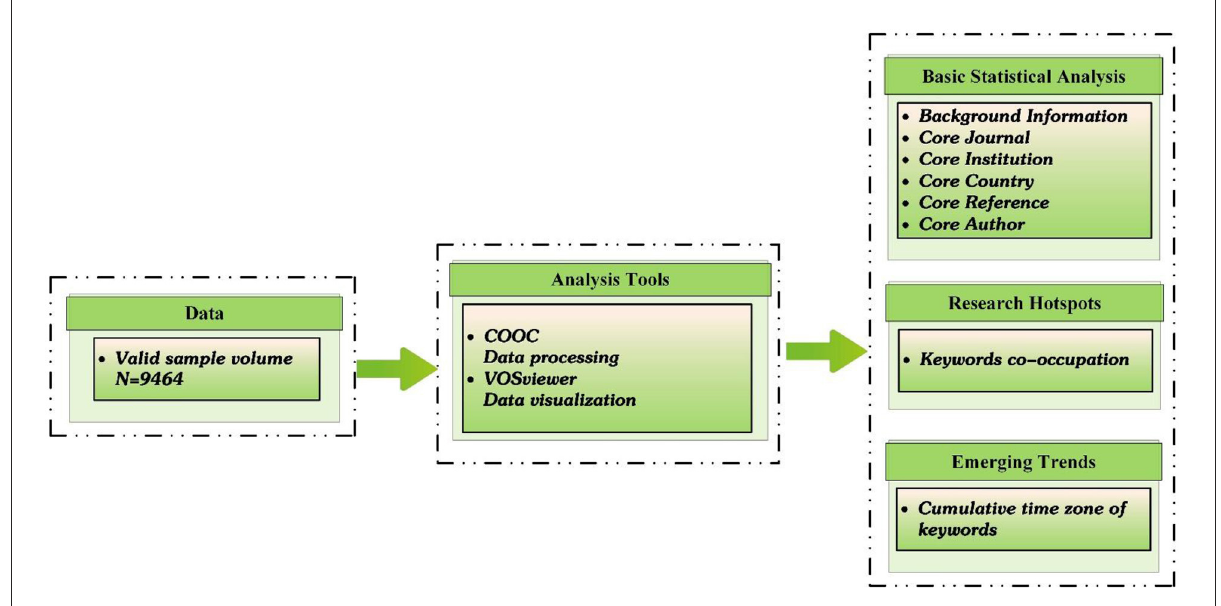
FIGURE1 Flow chart of the research process.